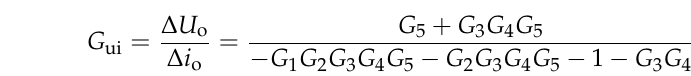
Figure 9. Bode plots under different R a .